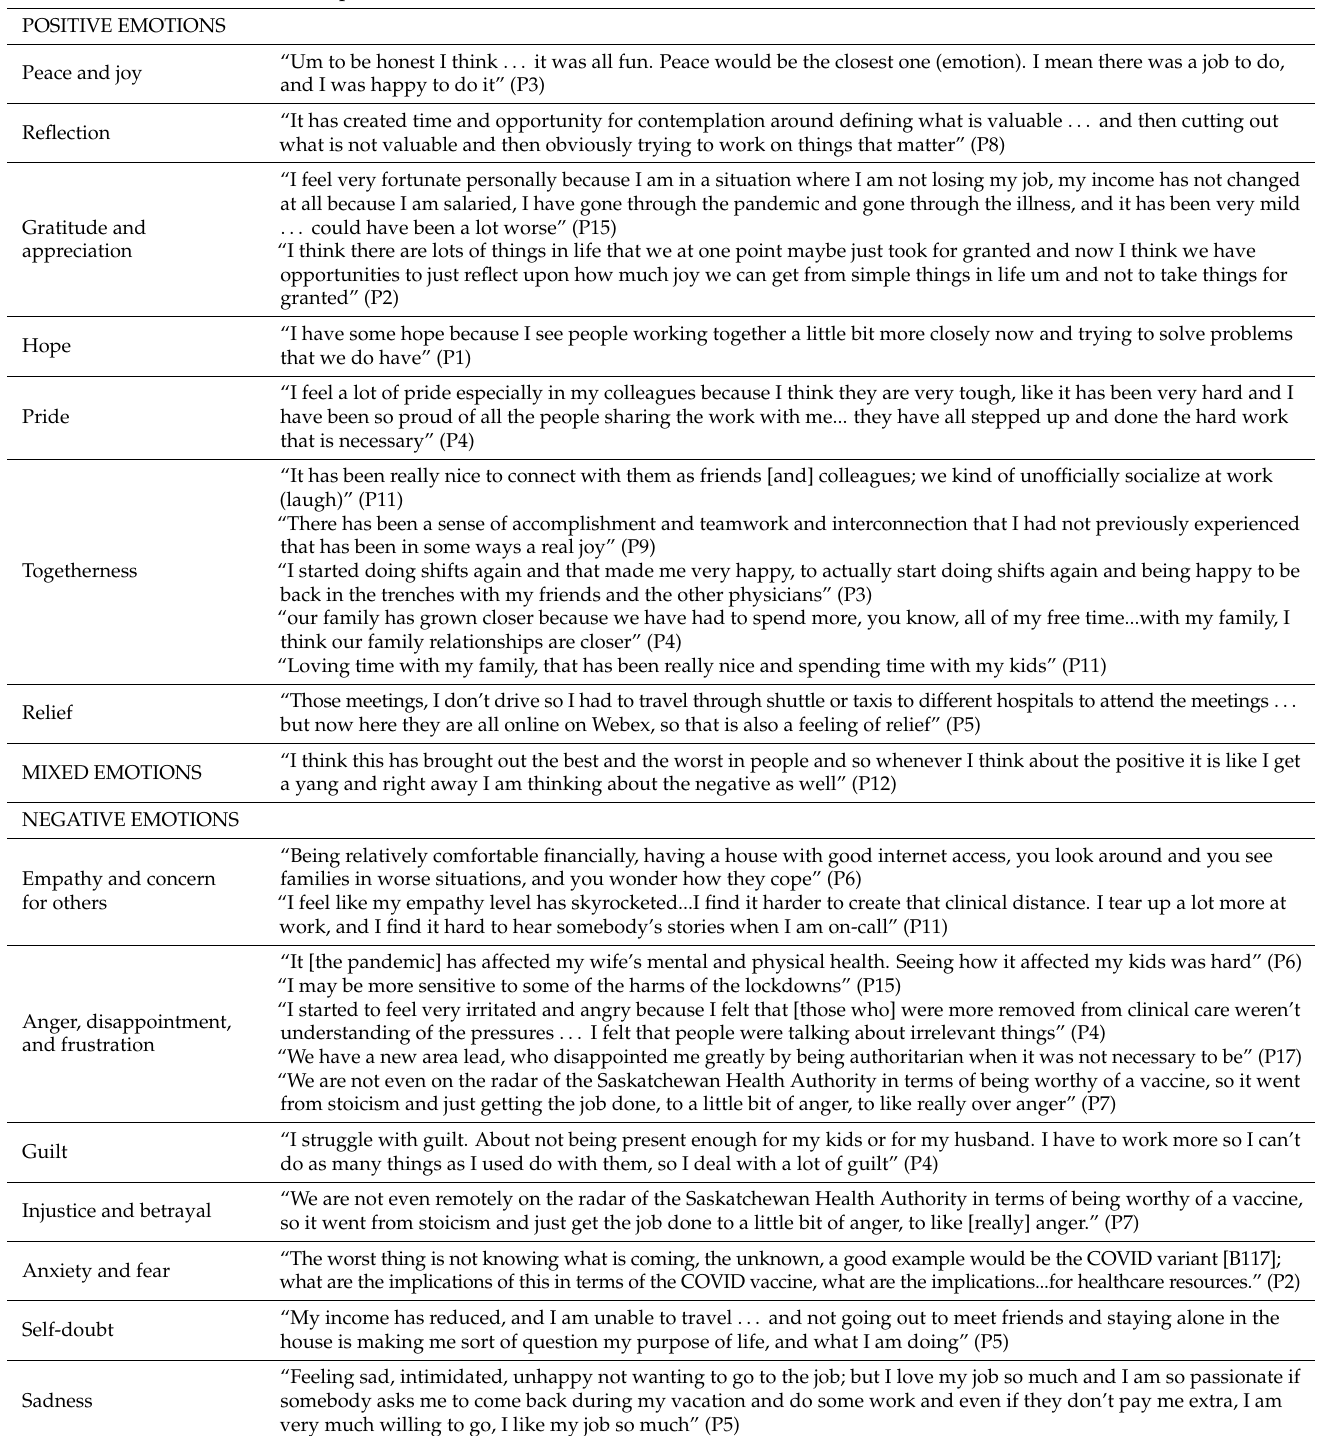
Table 3. Themes and subthemes with associated quotes as the physicians shared the main emotions they experienced in their personal and professional lives during the COVID-19